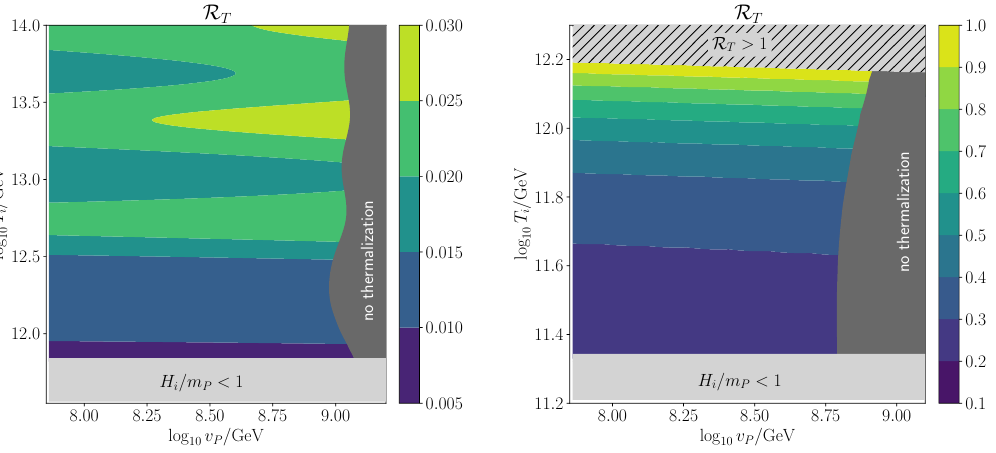
Figure 9 . R T in the n = 10 ( n = 8 ) scenario on the left (right)